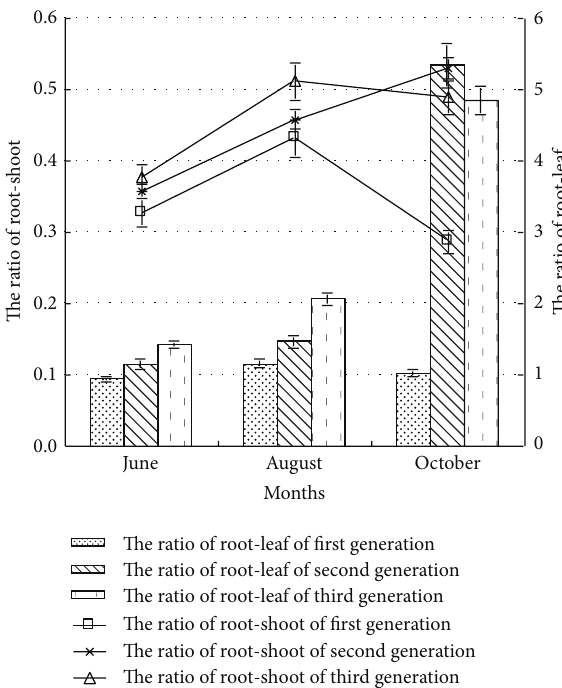
Figure 7: The ratio of root-shoot and root-leaf of poplar under different continuous